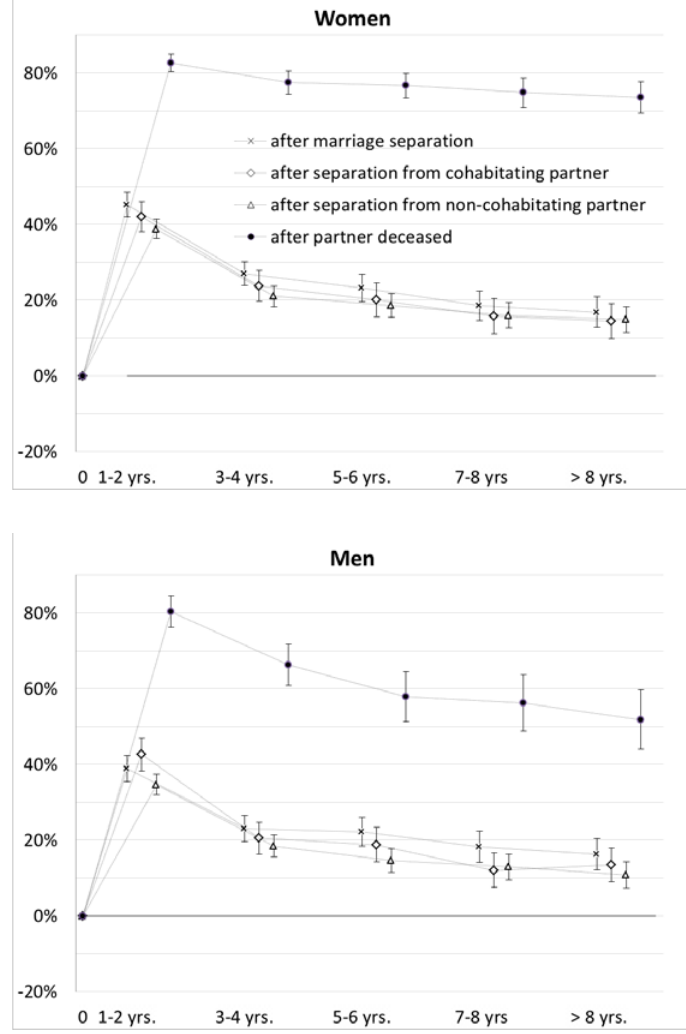
Figure 3 : Time-effects of relationship endings on social isolation (linear-probability models with fixed effects, percentage points and 95%-confidence limits) A) Primary-sphere: living alone and being without a